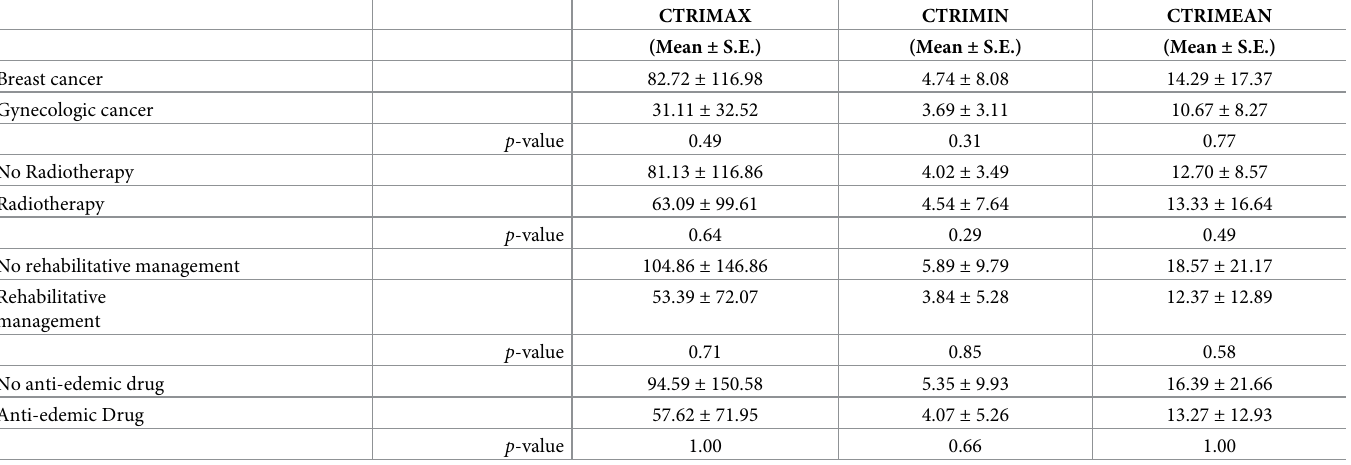
Table 2. Comparison of the CT reticulation indexes with other contributing